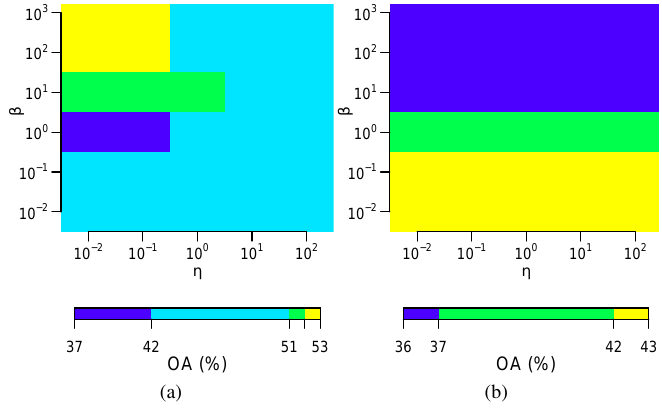
Figure 5. Comparison of our new spatial interaction model Fig. 5a and contrast Potts model Fig. 5b over a logarithmic scale.